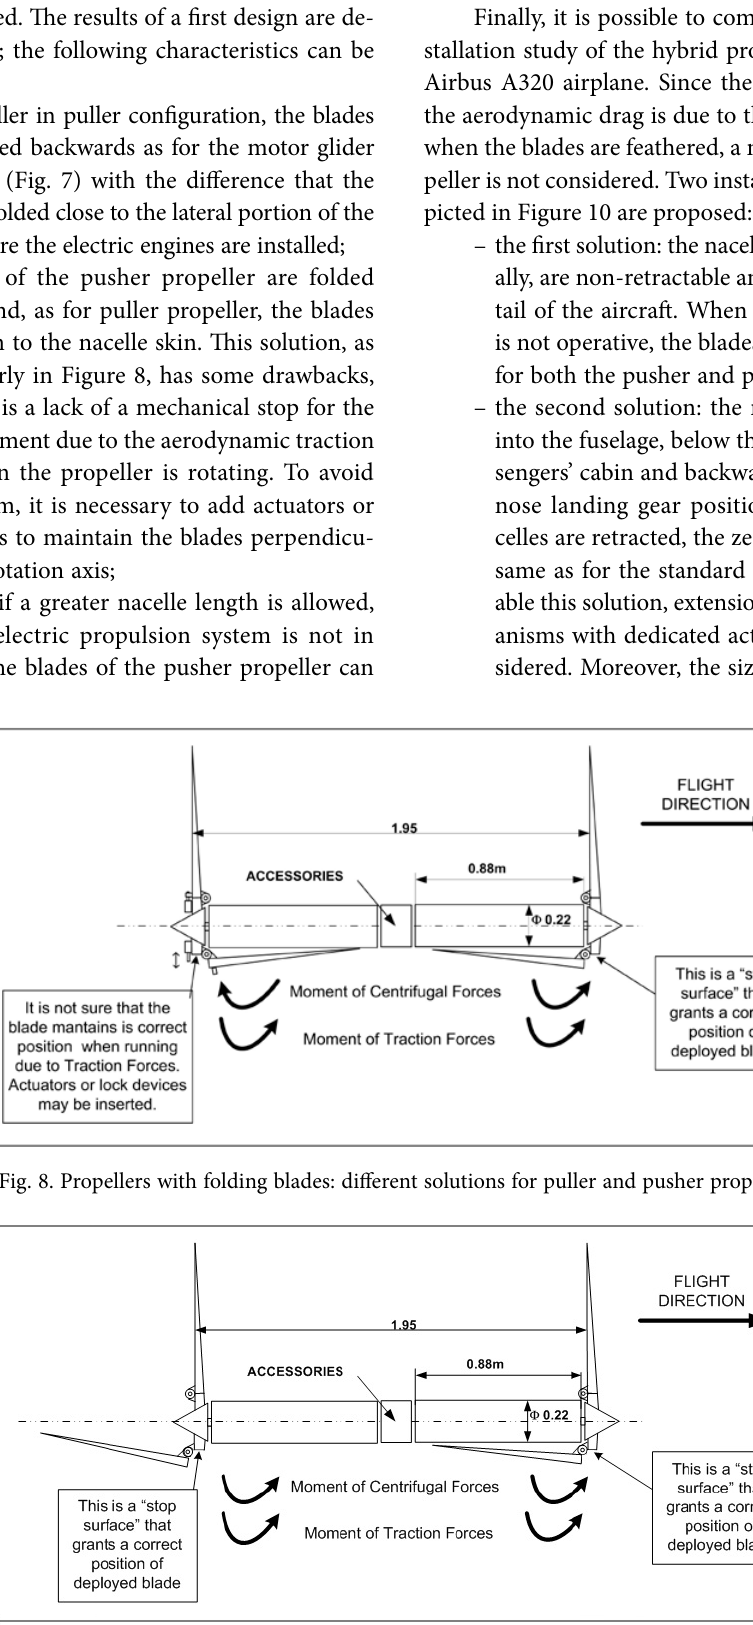
Fig. 9. Propellers with folding blades: similar solutions for puller and pusher